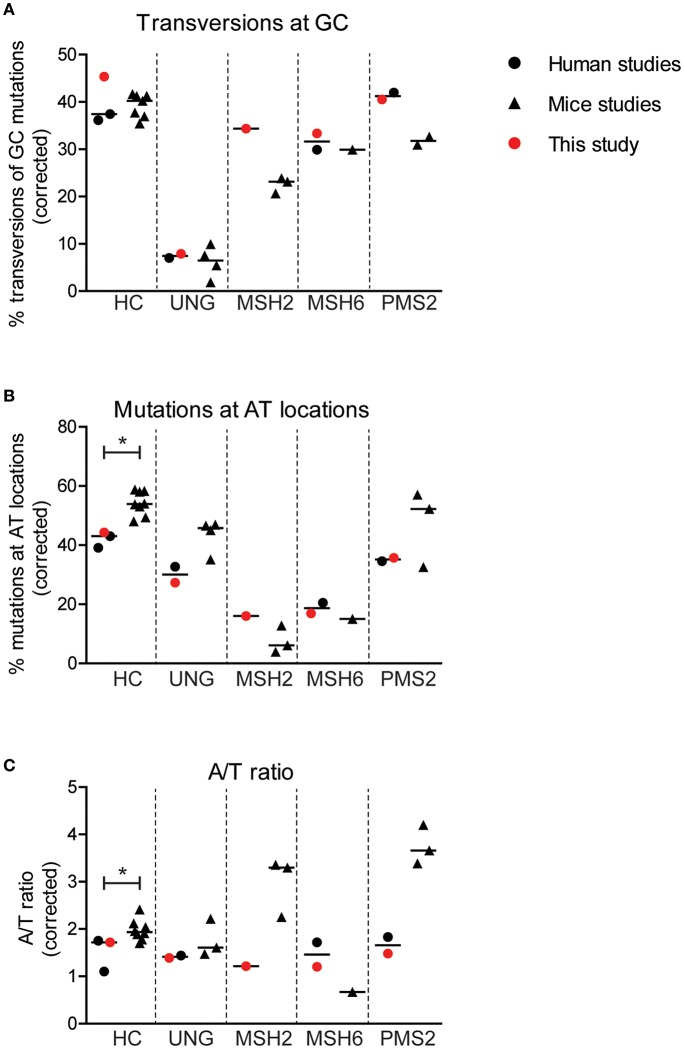
Minor differences are found in SHM patterns between mice and human. Differences in the percentage of GC mutations that are transversions (A), the percentage mutations at AT base pairs (B), and the A/T ratio (C) between mice and human with and without genetic defects in genes involved in BER or MMR. Statistical significance was performed using a Mann–Whitney test and indicated using *P < 0.05.